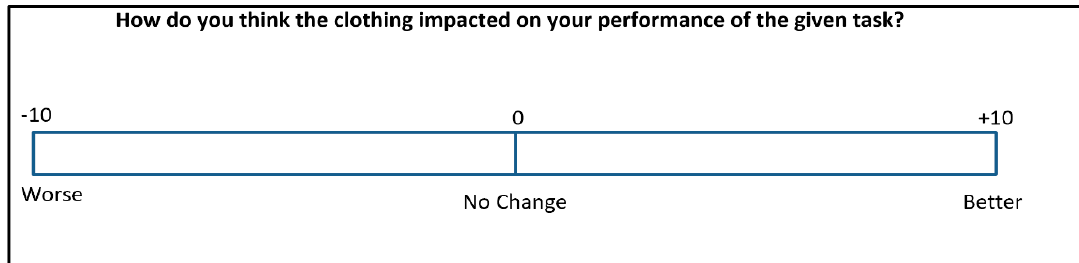
Figure 2. Visual Analogue Scale (VAS) rating scoring sheet.